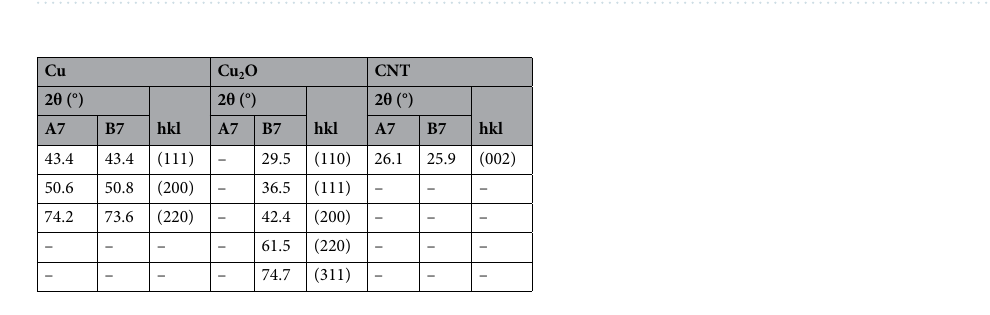
Table 3. GIXRD peaks assigned to the components of the coatings in A7 sample (ECD deposition time of 600 s,